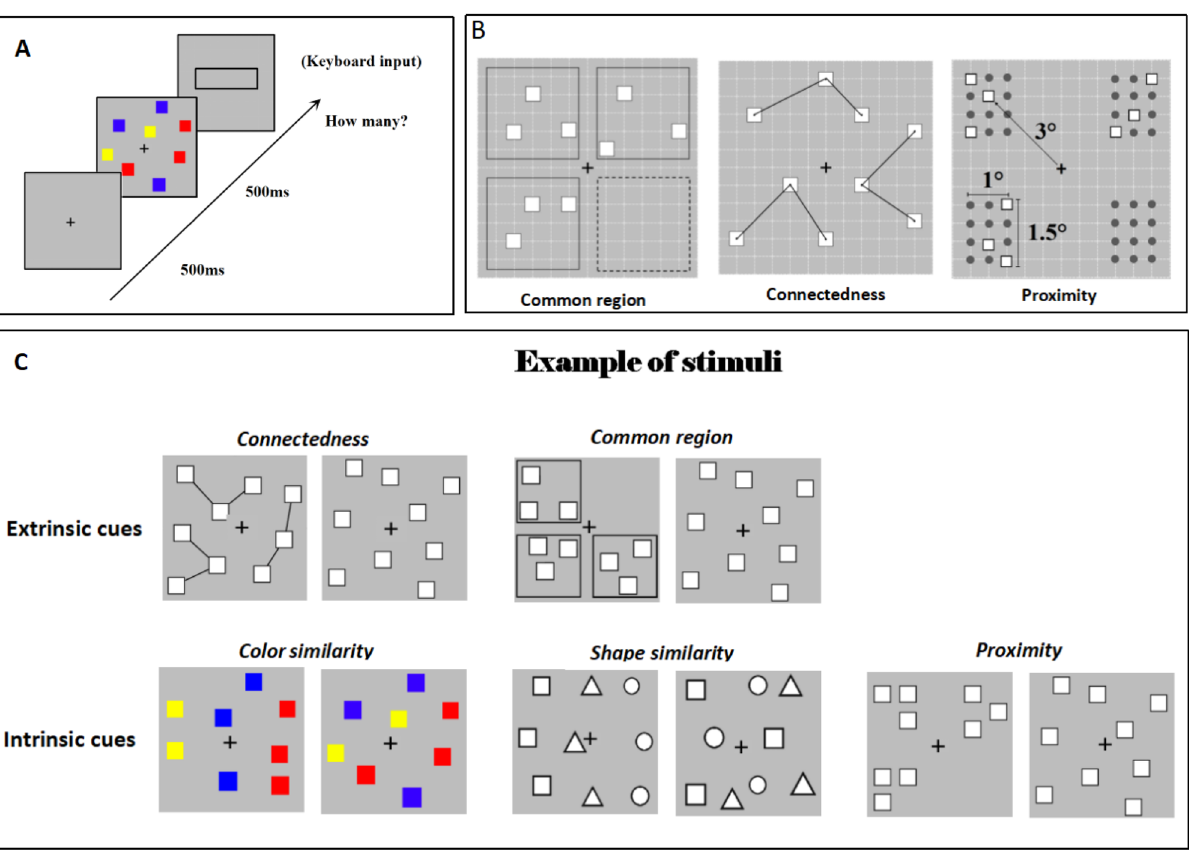
Figure 1. Illustration of the stimuli and procedure. ( A ) Example of the time course of the experiment. ( B ) Illustration of how stimulus position was defined in the grouping conditions. ( C ) Example of stimuli. Stimuli are not depicted to scale. Stimuli figures can be found as supplemental figures on the OSF